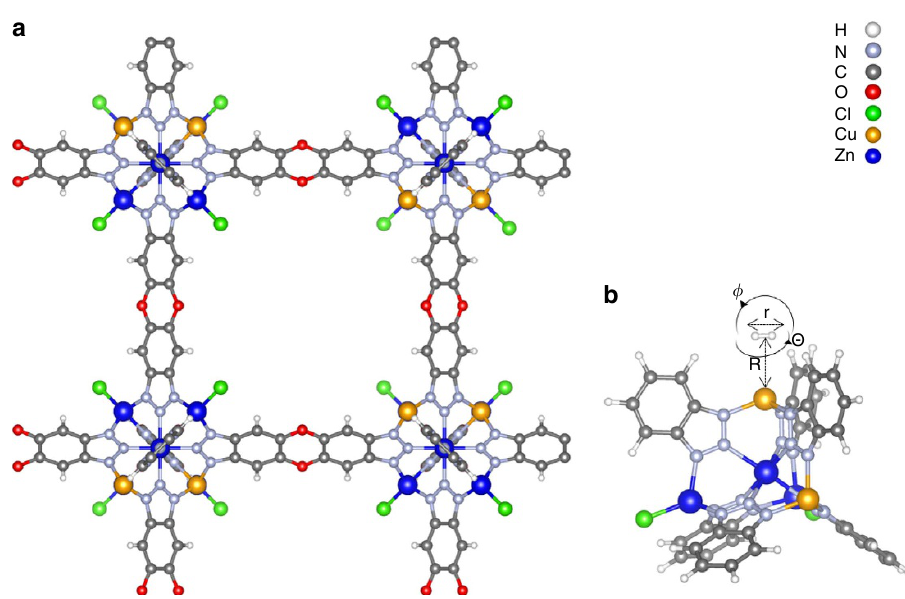
Figure 1 | Structural model of Cu(I)-MFU-4 l . H 2 adsorption in Cu(I)-MFU-4 l : cluster showing a full pore ( a ); computational model ( b ). R is the distance between Cu and H 2 centre; r is the H–H distance of adsorbed H 2 ; f is the angle of rotation of adsorbed H 2 in the plane normal to R , and Y is the angle of out-of-plane rotation. Colour scheme: white—H, light blue—N, grey—C, red—O, green—Cl, orange—Cu, dark blue—Zn.